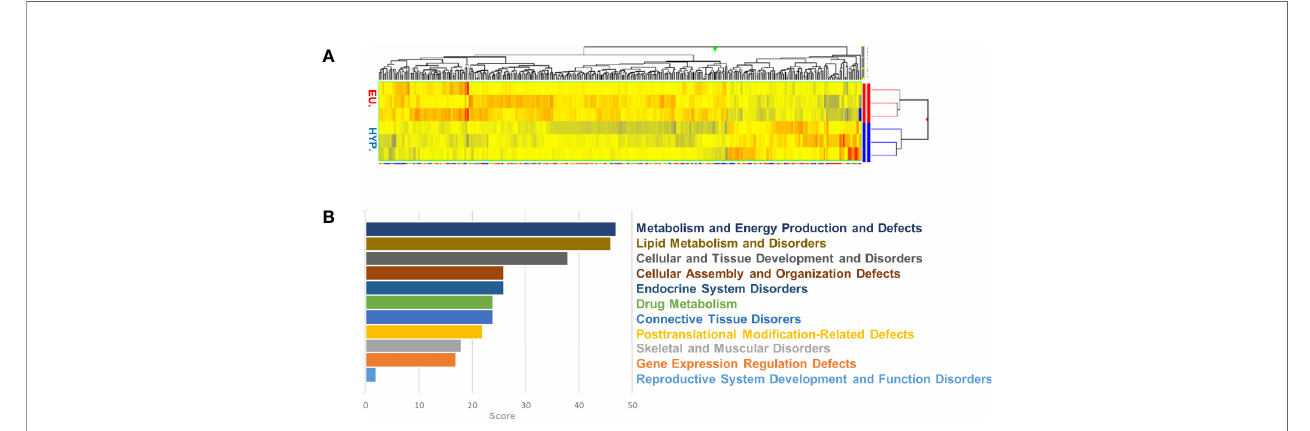
FIGURE 1 | Microarray analysis of human euthyroid and hyperthyroid skeletal muscle biopsies. Euthyroid and hyperthyroid SKM samples were analyzed by microarray. The color code for the signal strength is shown in which induced genes are indicated by red and repressed genes are indicated by blue (A) . Ontology of the related genes and their classi fi cation by GO terms (B)